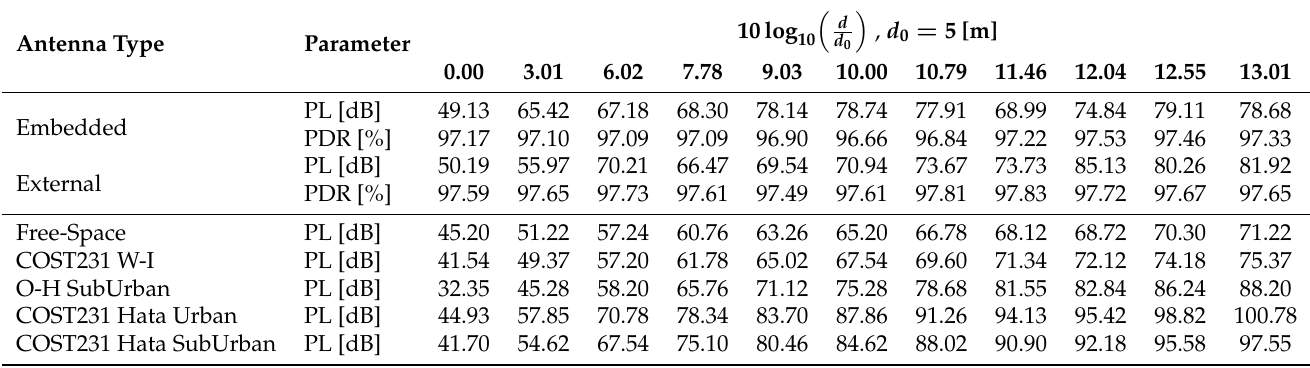
Table 6. Measured average path loss and Packet Delivery Ratio for Line-of-Sight